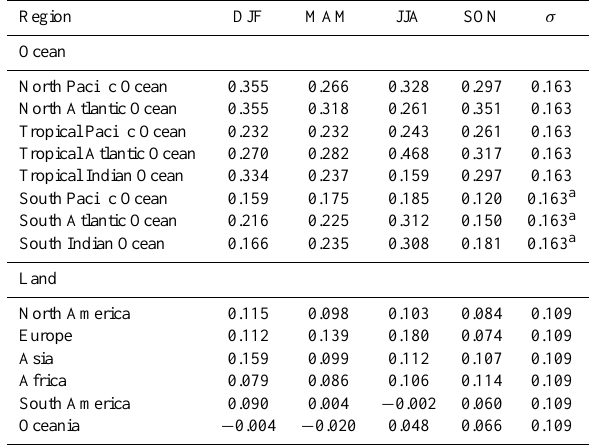
Table 4. Seasonal and regional sensitivities ∂ ln N d /∂ ln τ of cloud droplet number concentrations N d to changes in aerosol optical depth τ used in this study. The 14 regions are as defined in Fig. 1 of Quaas et al. (2008). σ is the standard deviation as used in the Monte-Carlo uncertainty analysis (Section 7) and applies to all sea- sons. Note a : Except in latitude band 20–30 ◦ S where σ is